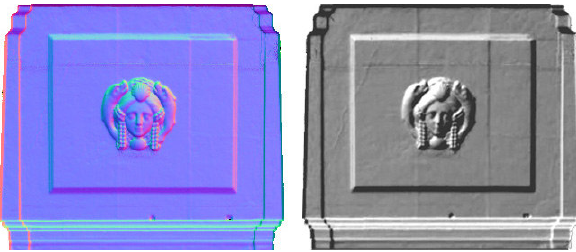
Figure 7. Displacement mapping to reduce the number of polygons. Left: Normal map, Right: